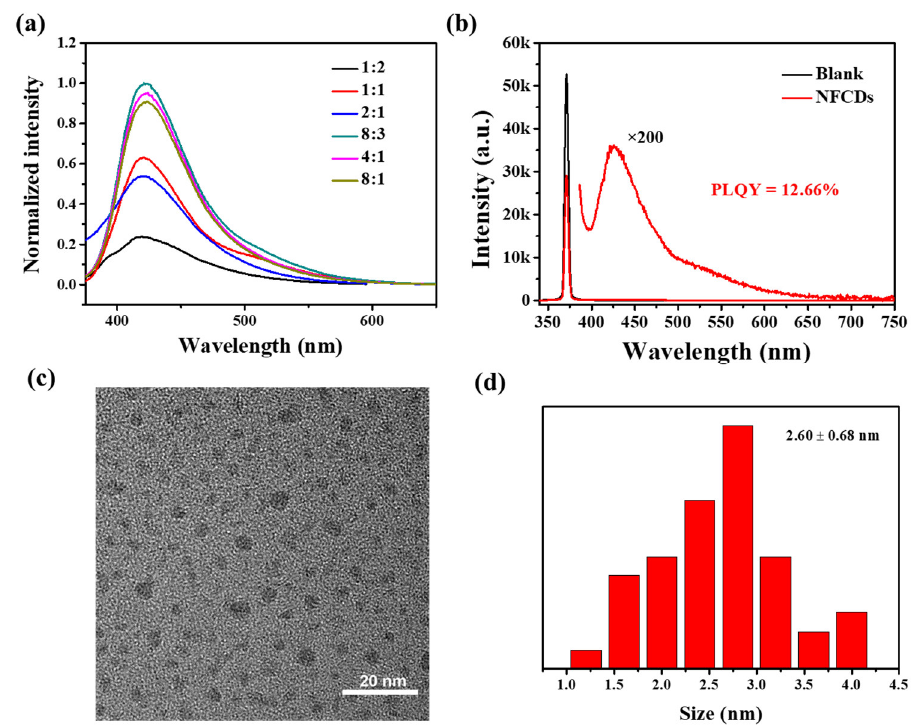
Figure 1. ( a ) Fluorescence intensity spectra of 3-aminophenol and 2,4-difluorobenzoic acid reacted at different ratios. ( b ) Fluorescence quantum yield of NFCDs when the ratio of -aminophenol and 2,4-difluorobenzoic acid is 8/3. ( c ) TEM image of NFCDs. ( d ) Particle size distribution diagram of NFCDs.